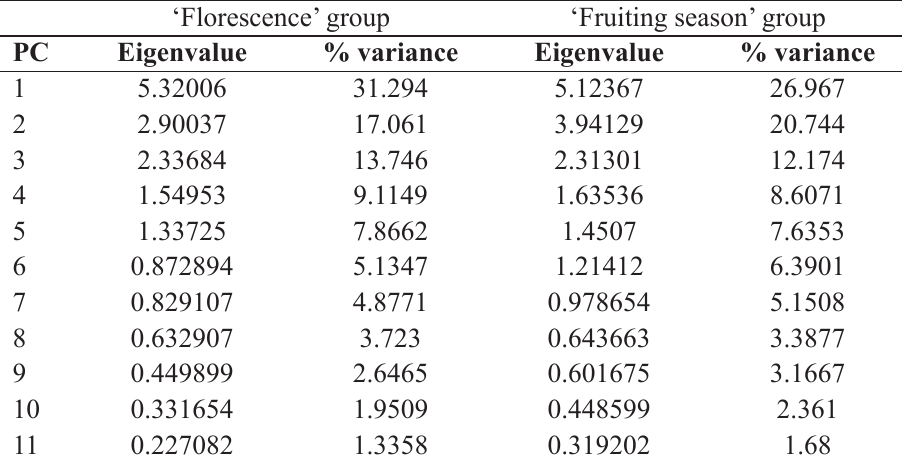
Table 2. Eigenvalues and variance (%) obtained from PCA.